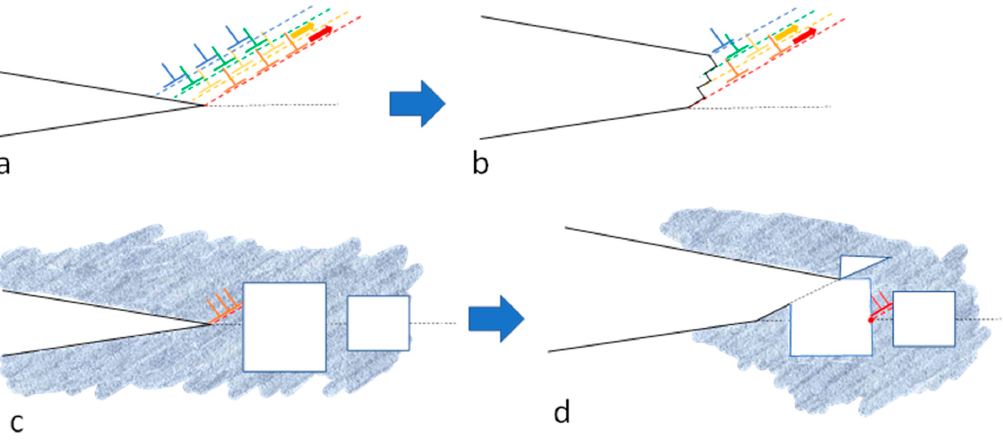
Figure 20. Schematic diagram illustrating the possible effect of a having high density of grain bound- ary cavities on inter-granular fracture: ( a ) grain boundary crack that emits dislocations; ( b ) crack blunting effect when the deformation at the crack tip is unconstrained; ( c ) crack on a perforated boundary emitting dislocations; ( d ) dislocations have to cut through the nearest cavity, effectively blunting the crack, and create a hinge that re-centres the deformation on the grain boundary.